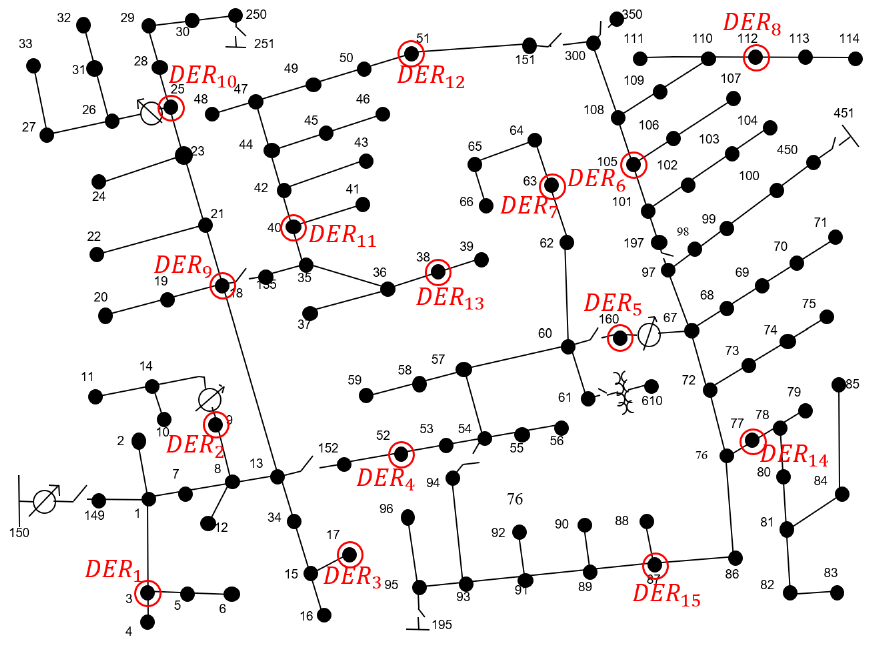
Figure 2. The IEEE 123-bus system including 15